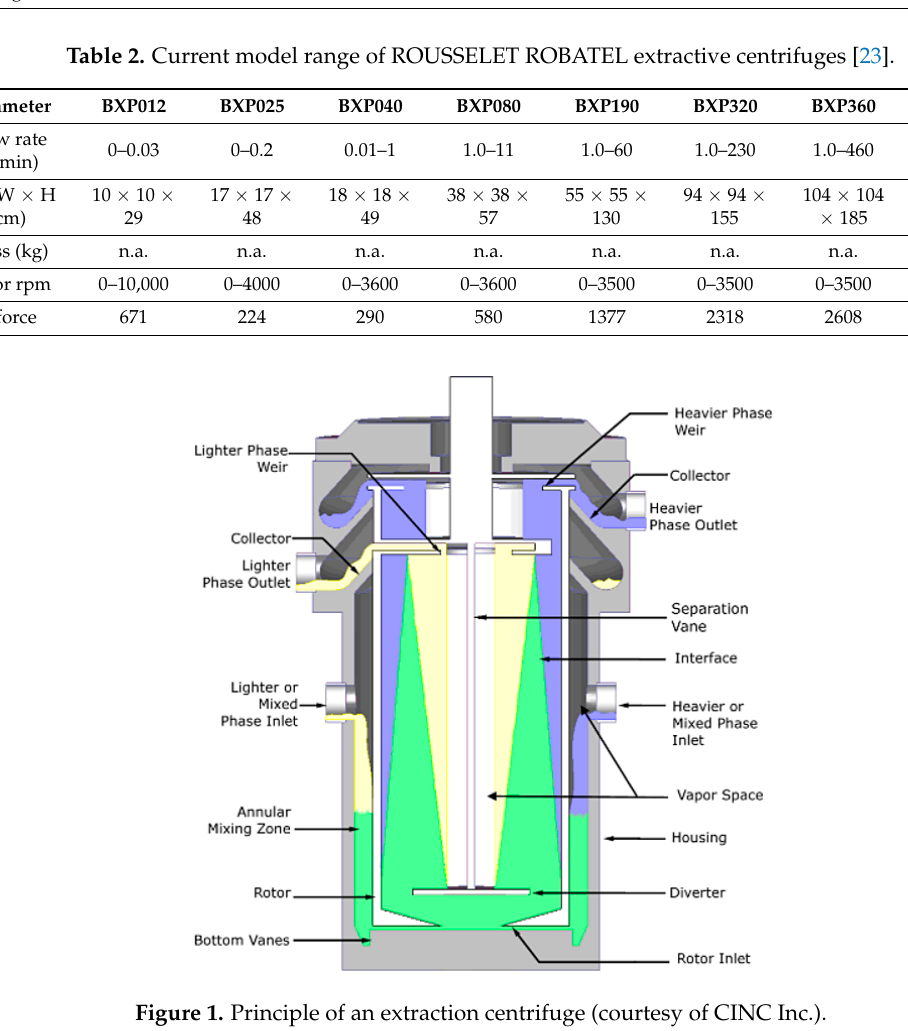
Figure 1. Principle of an extraction centrifuge (courtesy of CINC Inc.)